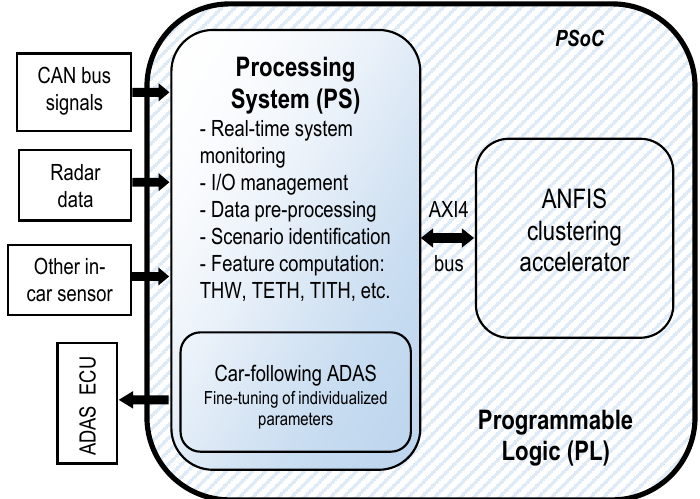
Figure 2. Block diagram of the field-programmable gate array (FPGA)-based intelligent sensor for online car-following